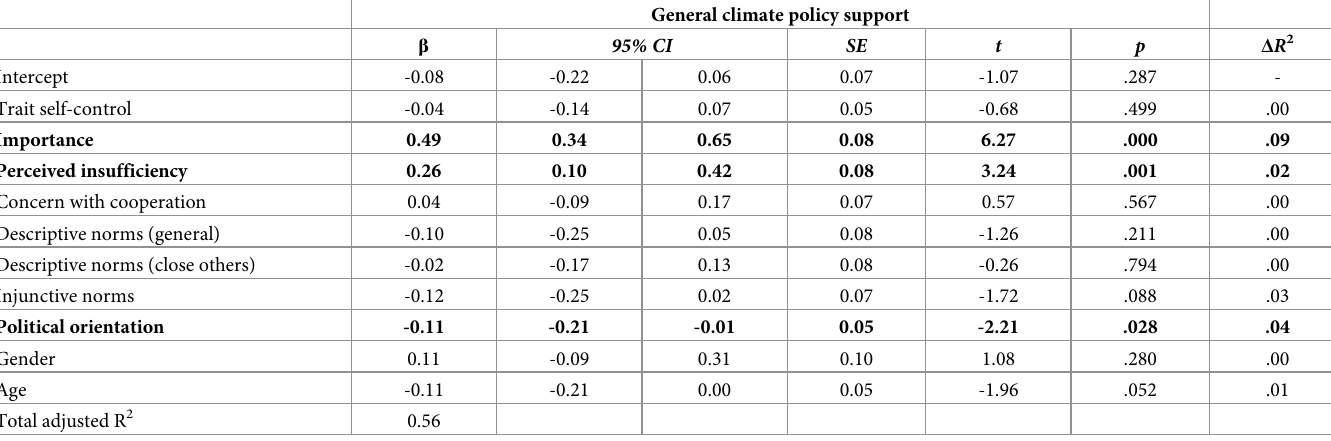
Table 4. Results of a regression model predicting general climate policy